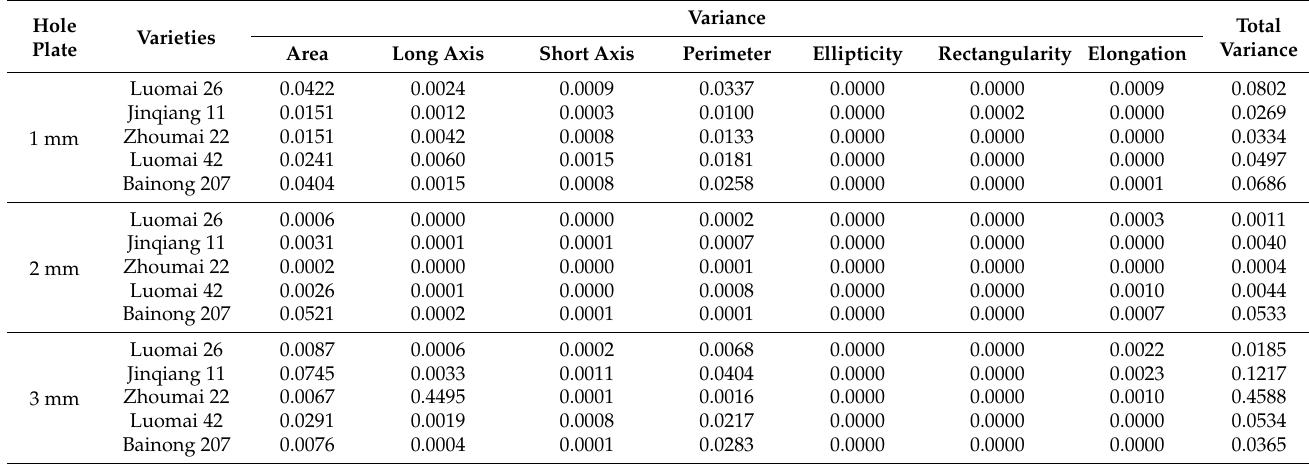
Table 2. Variances in different hole plate detection characteristic parameters.